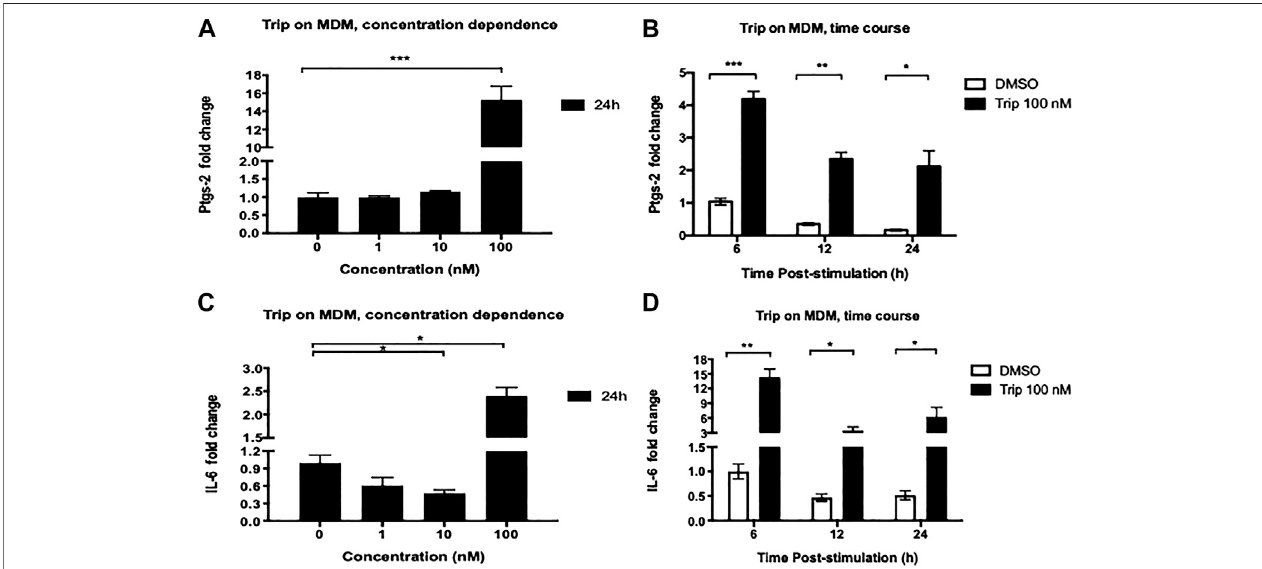
FIGURE 2 | Triptolide treatment modulates the expression of lncRNA-associated pro-in fl ammatory genes Ptgs-2 and IL-6 in resting monocyte-derived macrophages (MDMs). Concentration dependence (A, C) : MDMs were treated with increasing concentrations of triptolide for 6 and 24 h. DMSO was used as a vector control. Total RNA was extracted, and then Ptgs-2 (A) and IL-6 (C) expression levels were assessed by RT-qPCR. Time dependence (B, D) : MDMs were treated with 100 nM triptolide for 6, 12, and 24 h. DMSO was used as a vector control. Total RNA was extracted, and then Ptgs-2 (B) and IL-6 (D) expression levels were assessed by RT-qPCR. Relative expression was calculated using the − ΔΔ Ct method. * p < 0.05; ** p < 0.01; *** p <